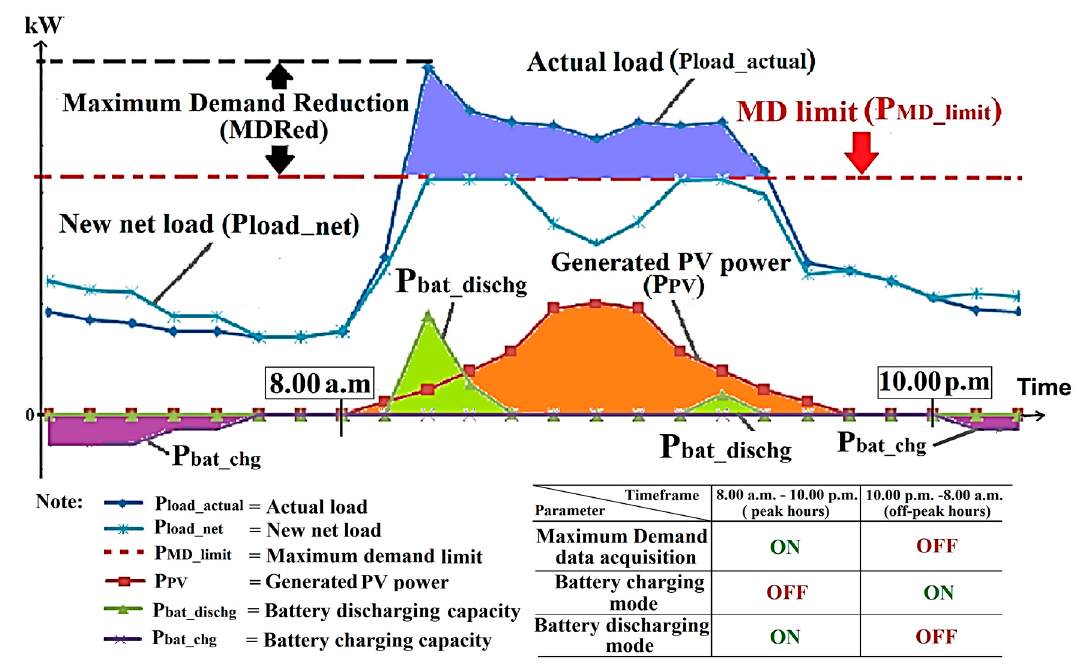
Figure 1. Peak or maximum demand shaving concept using solar PV-battery system [13].